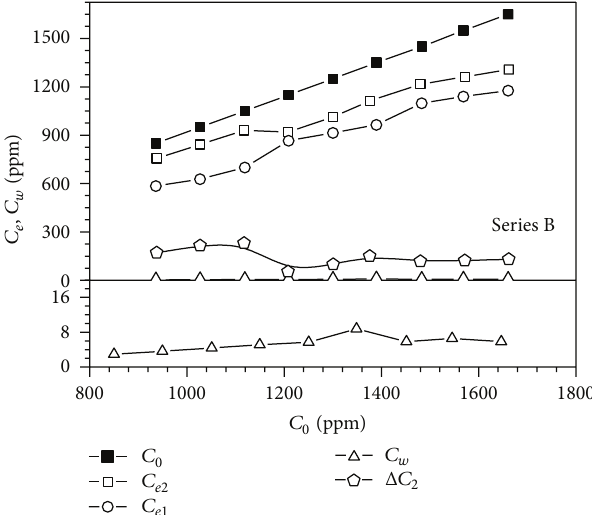
Figure 2: The adsorption experiment of two-phase and three-phase systems with the simulative water